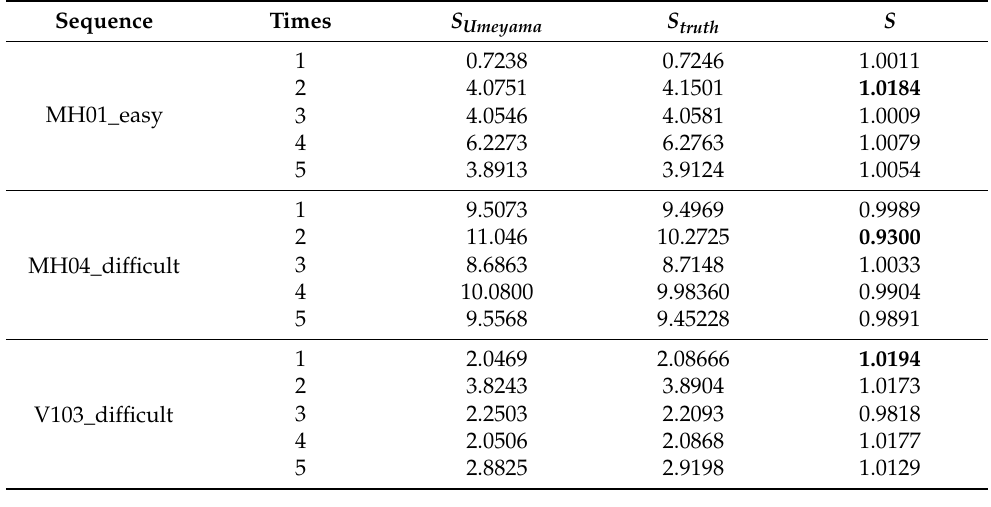
Table 1. Scale Comparision of Umeyama Estimated against the Truth.